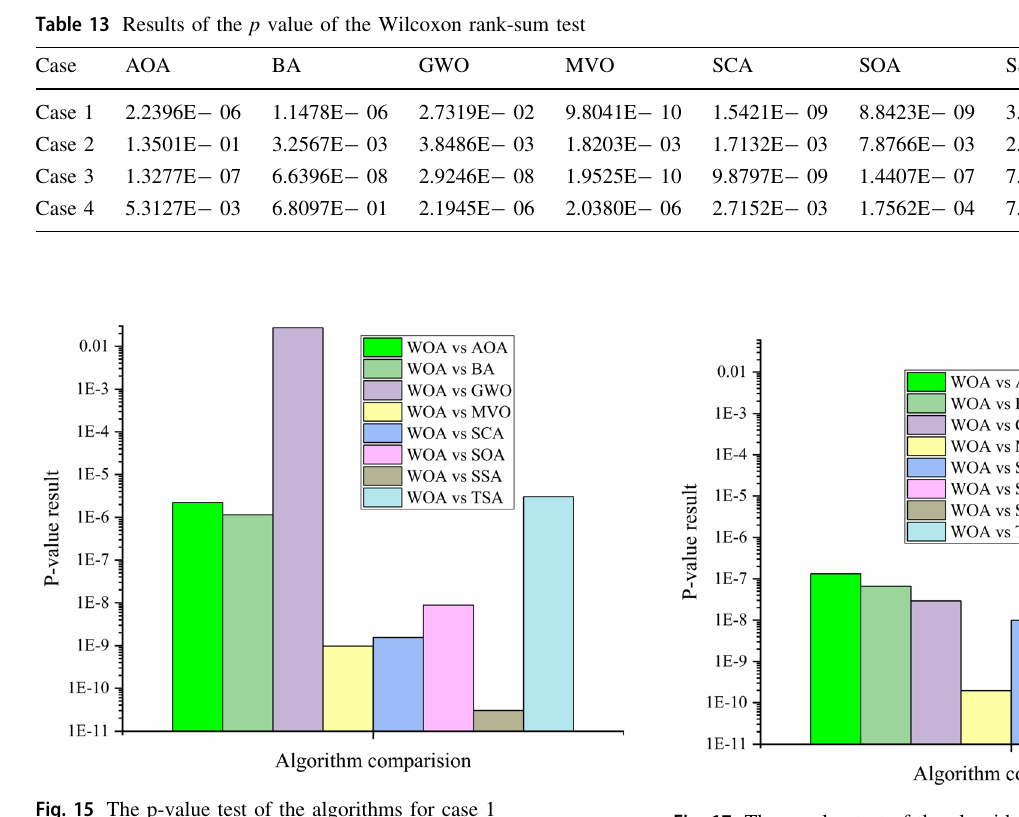
Fig. 17 The p-value test of the algorithms for case 3